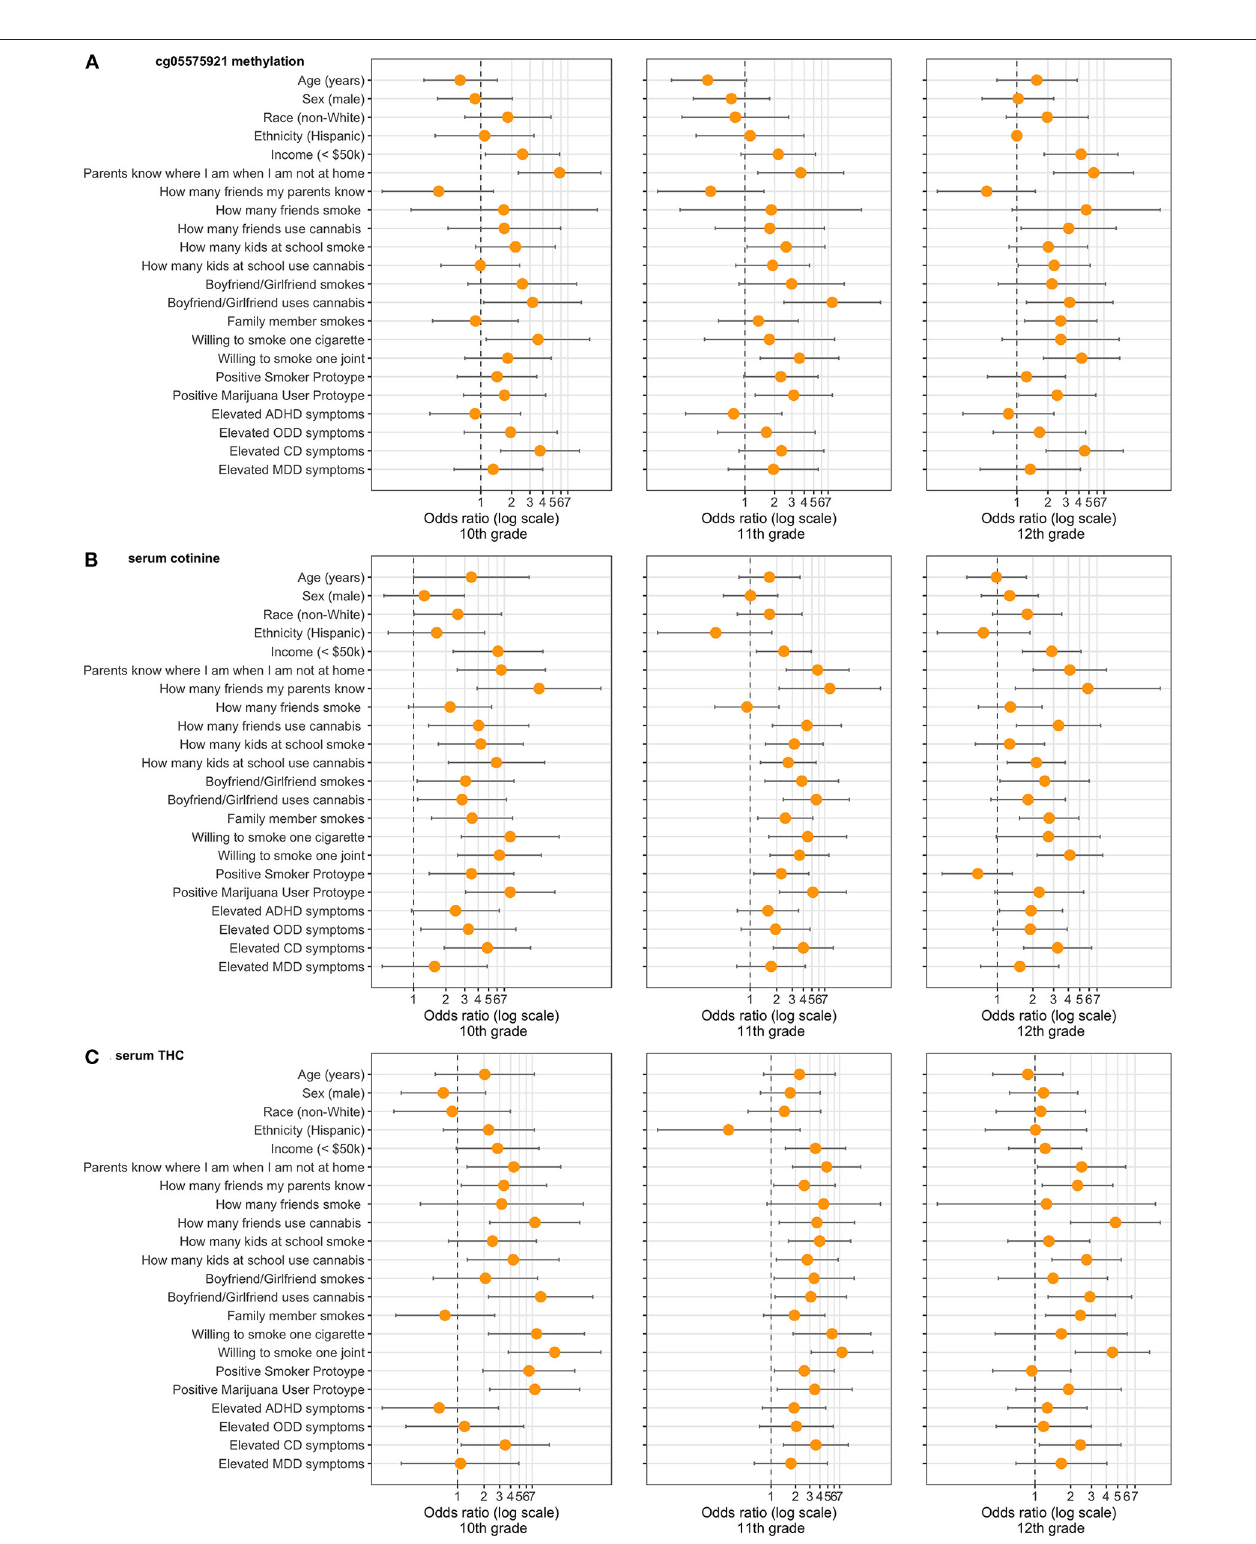
FIGURE 3 | Demographic, environmental, and behavioral risk factors ascertained in 10th grade and Odds Ratios for (A) epigenetic positivity (cg05575921 methylation), (B) cotinine positivity ( > 3ng/mL), and (C) THC positivity ( > 0.5ng/mL) positivity in 10–12th grade ( n = 442). Only participants who endorsed having